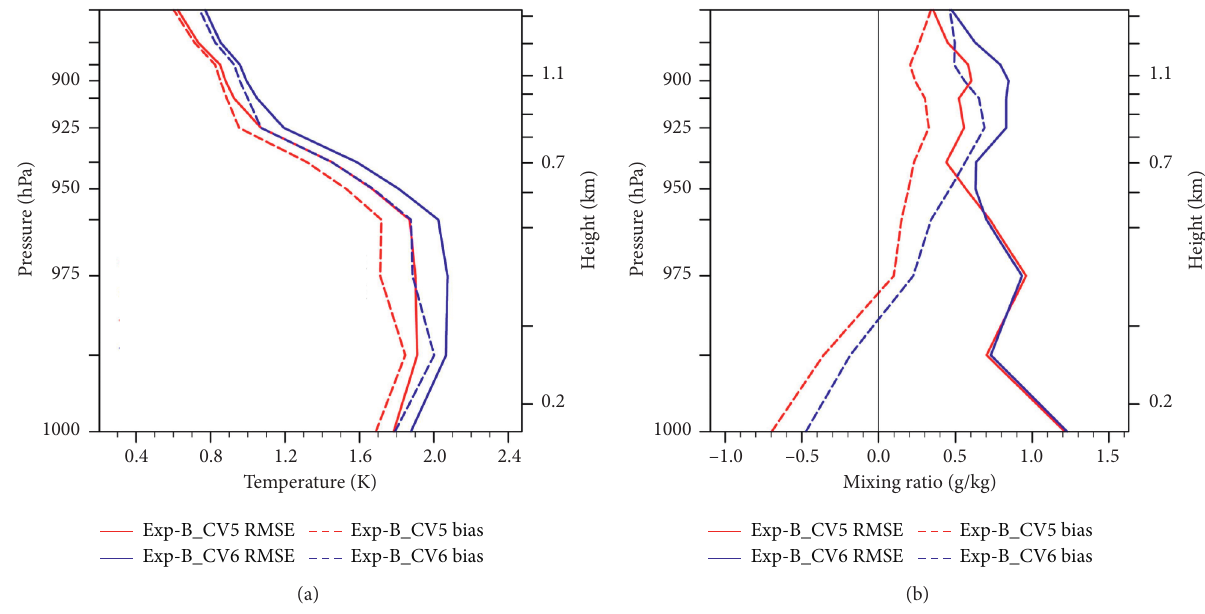
Figure 13: Vertical profiles of root mean square errors (RMSEs) (solid lines) and biases (dashed lines) between the initial analysis and the radiosonde observations of temperature (a) and mixing ratio (b) for Exp-B_CV5 and Exp-B_CV6.